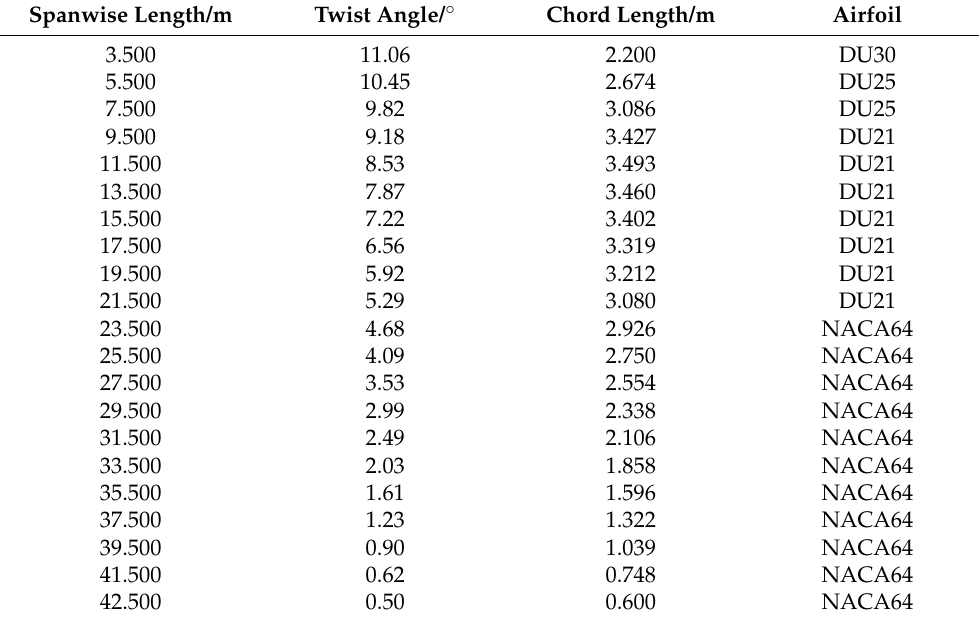
Table 2. Designed blade chord, twist angle, and airfoil